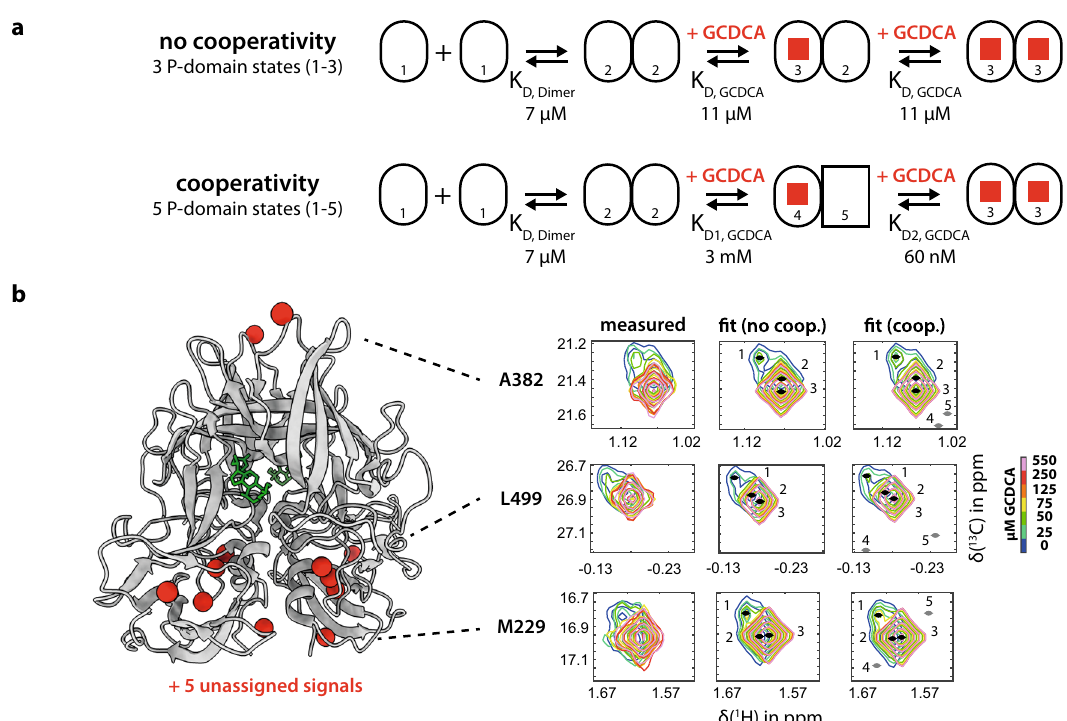
Fig. 5 Possible GCDCA binding models. a Methyl TROSY-based GCDCA titration data (Fig. 4) match two binding models: a 3-state binding model in which dimerization is followed by two consecutive, independent binding events with a dissociation constant K D of 10.5 µ M and a model with strong cooperativity in which binding of the fi rst GCDCA molecule dramatically increases the af fi nity for the second. In both models, the monomeric protein (1) is binding-incompetent and is depleted at higher ligand concentrations by removal of the unbound dimer (2) through subsequent binding reactions. b Using TITAN, both binding models were fi tted to titration data where cross-peaks of monomeric (1), dimeric (2), and ligand-bound states (3) were at least partially resolved. Cross-peaks of A382, L499, and M229 are shown as examples (for the complete set of cross-peaks see Fig. S22). Note, that strong cooperativity inherently implies the existence of two unobservable P-domain states (4) and (5) in the single-bound dimer. Signal positions corresponding to these states were positioned randomly during the fi t procedure. The dissociation constant K D,Dimer was determined independently by TITAN analysis of a P-domain concentration series (Fig.